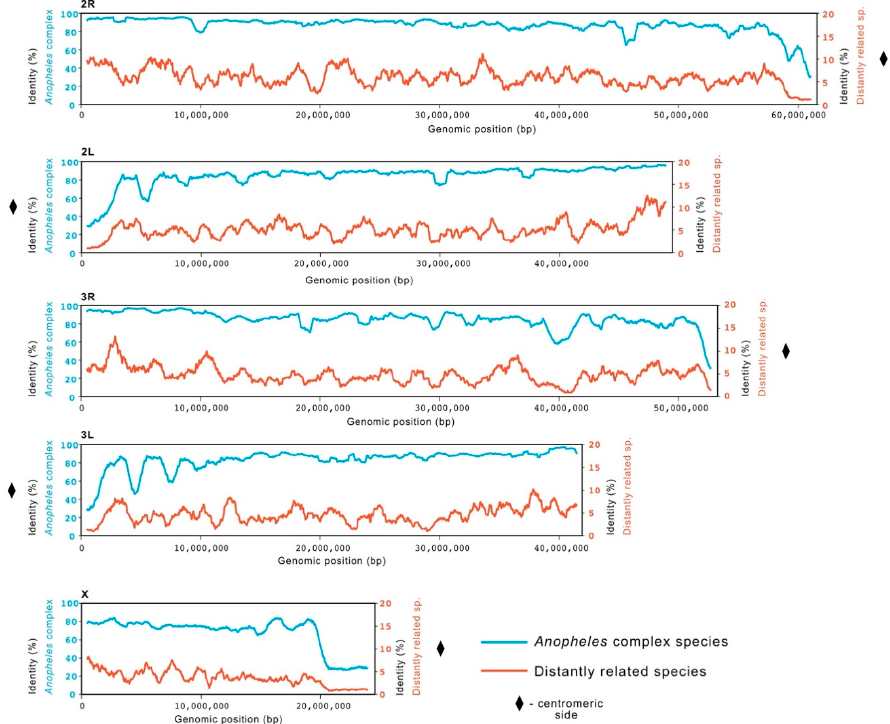
Figure 1. Conservation across An. gambiae chromosomes. A sliding window of length 1 Mb was used to calculate average identity (in percentage) for two groups of species in comparison to An. gambiae . A comparison with a group of five species of the Anopheles gambiae complex (in blue; left scale 0–100%), namely An. coluzzii , An. arabiensis , An. quadriannulatus , An. melas and An. merus, showed high average identity (81%) across the genome. The group of species more distantly related to An. gambiae (in red; right scale 0–20%), namely An. darlingi , An. albimanus , Aedes aegypti , Culex quinquefasciatus , Drosophila melanogaster, showed lower average identity (<5%). A decrease in conservation in both groups can be observed closer to the centromeric regions of each chromosome arm (represented by ♦ ).